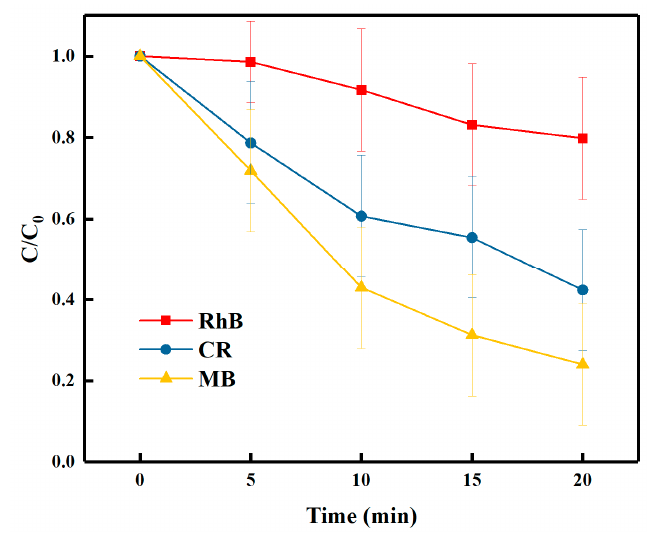
Figure 9. Effect of the type of organic dye on sonodegradation. Experimental conditions: [Dye concentration] = 25 ppm, [sonocatalyst] = 1 g/L, [H 2 O 2 ] = 4 vol %.